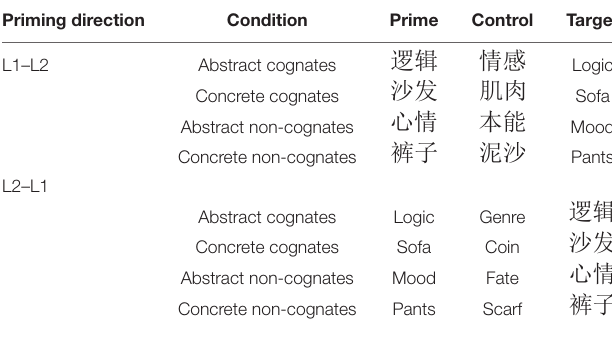
TABLE 1 | Stimuli examples in Experiments 1 and